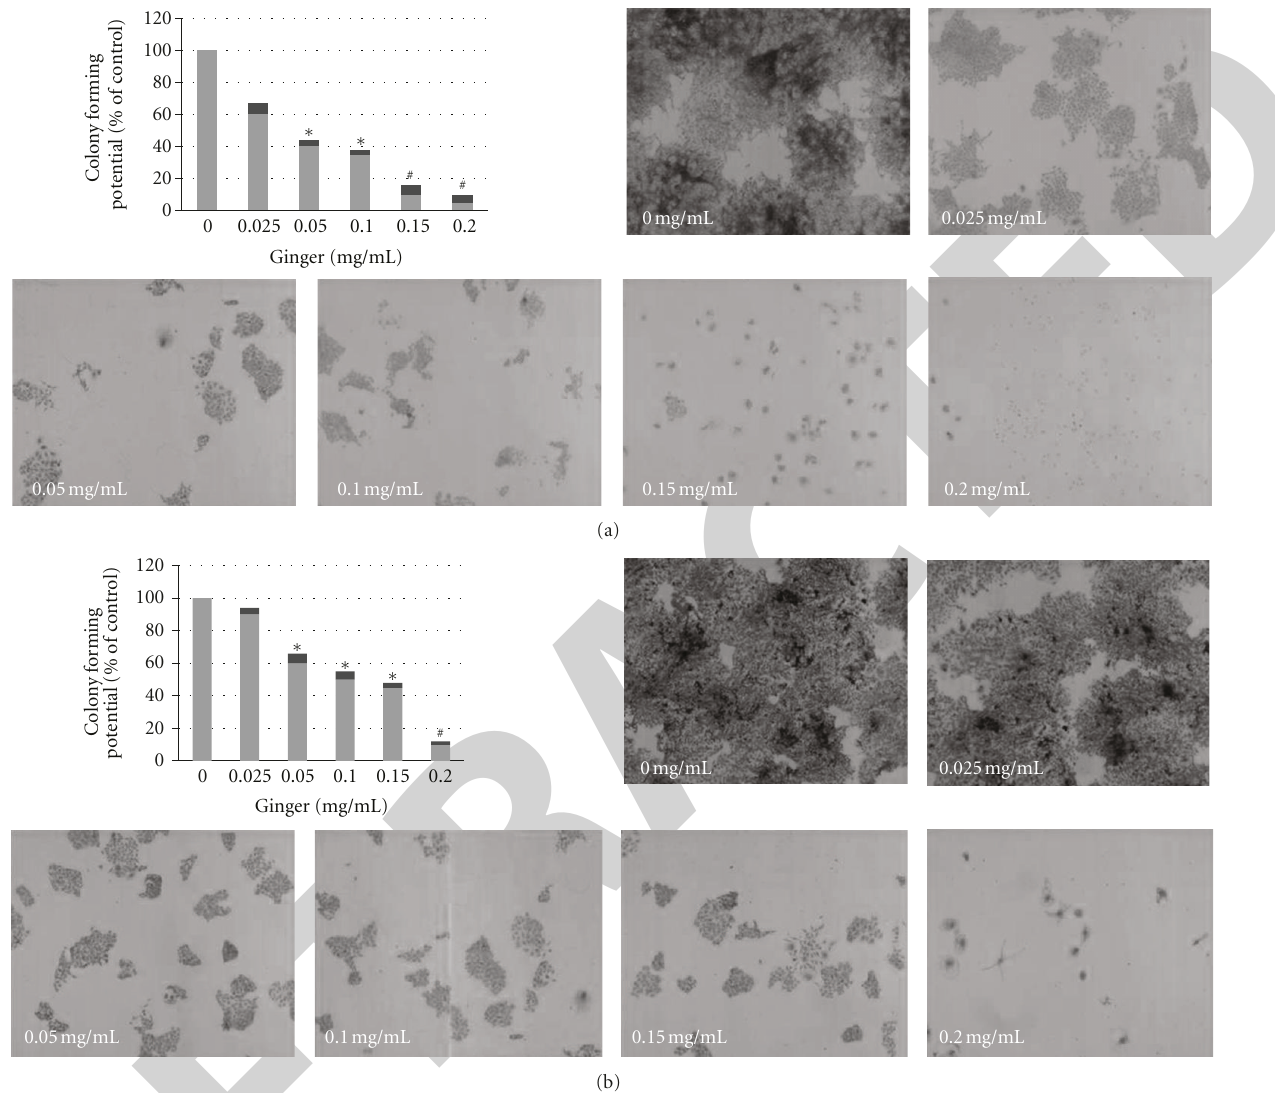
Figure 2: Ginger extract inhibits clonogenicity of MCF-7 and MDA-MB-231 cells. Cells were seeded onto a 6-well plate at 300/well and treated with indicated concentrations of the ginger extract of ginger for 10 days . A survival of 100% corresponds to the number of colonies obtained with cells that were not treated with ginger extract (control culture). Dose-dependent colony formation inhibition was clearly evident. The experiment was repeated five times in triplicates, and the colony-forming potential of the cells at each dose of ginger is expressed in terms of percent of control and is reported as the mean ± SD. P < 0 . 05 ( ∗ ); P < 0 . 001 (#).